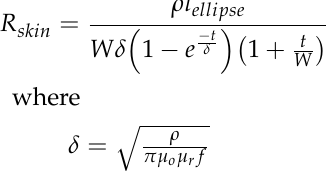
(cid:16) (cid:17) C parasitic